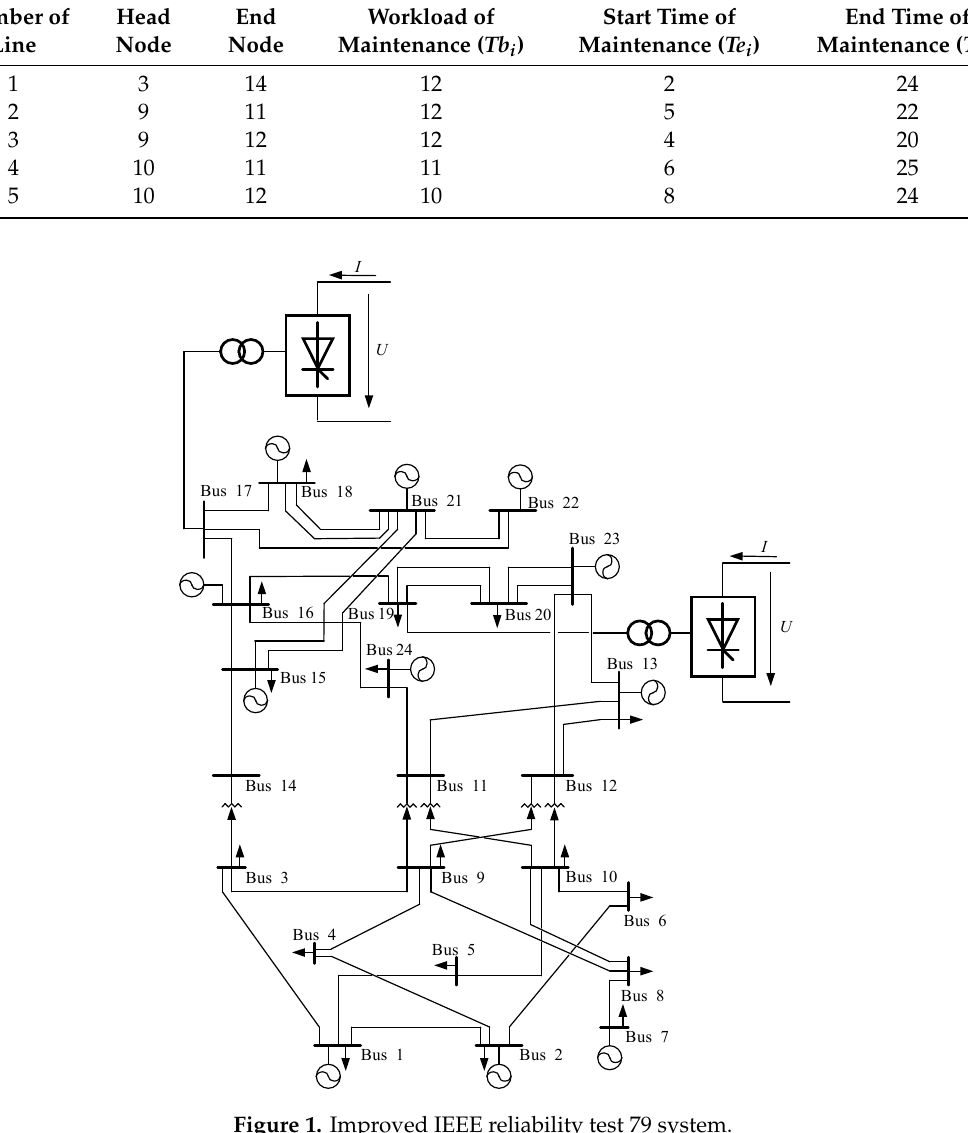
dj dj   Figure 2. Simulation for the state of the non-maintenance lines and DC transmission lines.